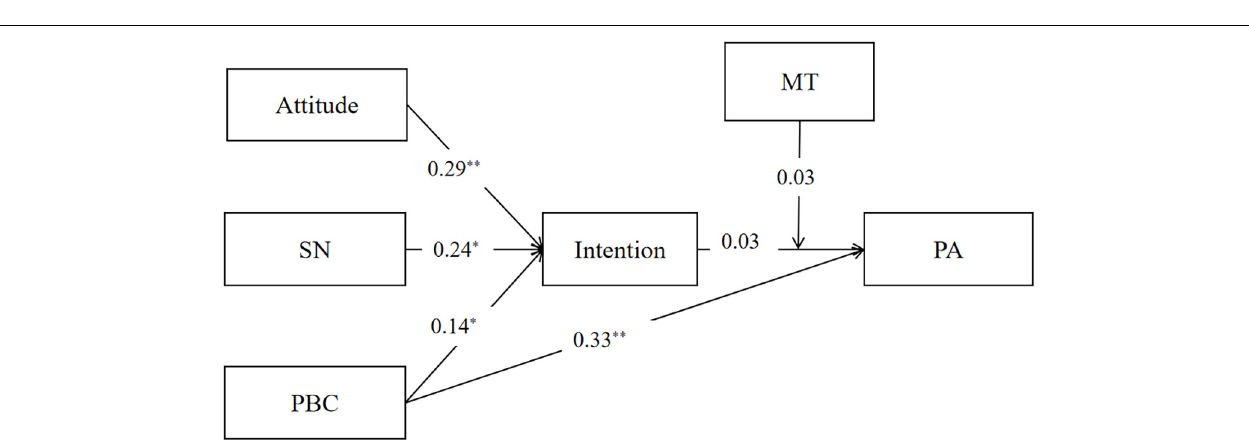
FIGURE 4 | Structural equation model of the moderation role of mental toughness on intention-behavior gap among wage earners. SN, subjective norm; PBC, perceived behavioral control; PA, physical activity; * p < 0.05, ** p < 0.01.